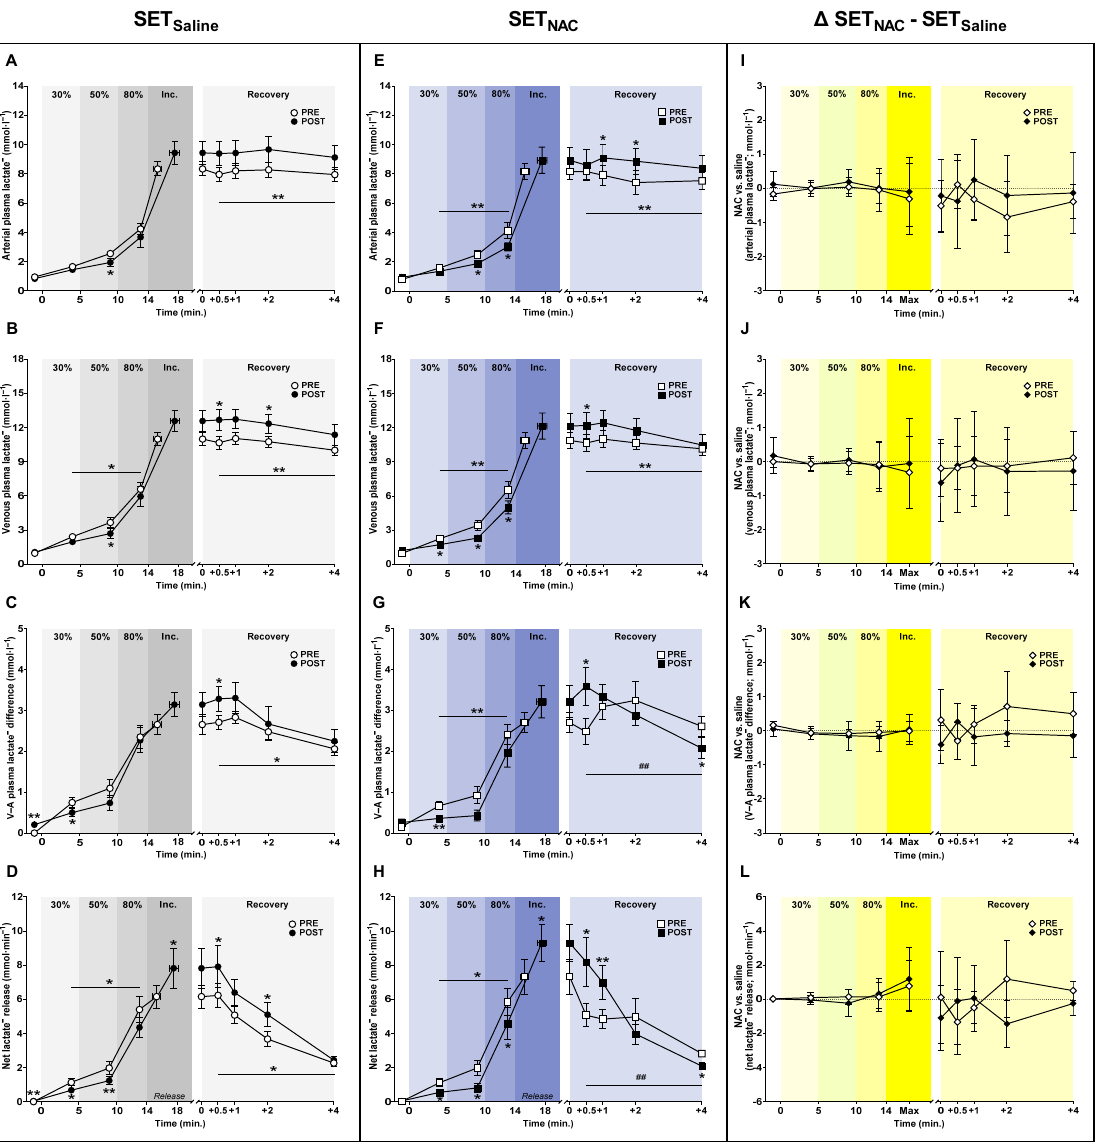
Figure 4. Effect of speed endurance training (SET) on plasma lactate − shifts without and with N -acetylcysteine infusion. Plasma lactate − concentrations ( A – C , E – G ) and net leg lactate − exchange ( D , H ) before, during, and after knee-extensor exercise without (SET Saline , n = 10) and with N - acetylcysteine (SET NAC , n = 9) infusion as well as difference ( ∆ ) between SET NAC and SET Saline ( I – L , n = 9) before (pre) and after (post) SET. ** Post different from pre ( p < 0.01). * Post different from pre ( p < 0.05). ## Trial × time effect ( p < 0.01). Data are presented as mean ± SEM (SET Saline and SET NAC ) or mean ± 95% CI ( ∆ SET NAC − SET Saline